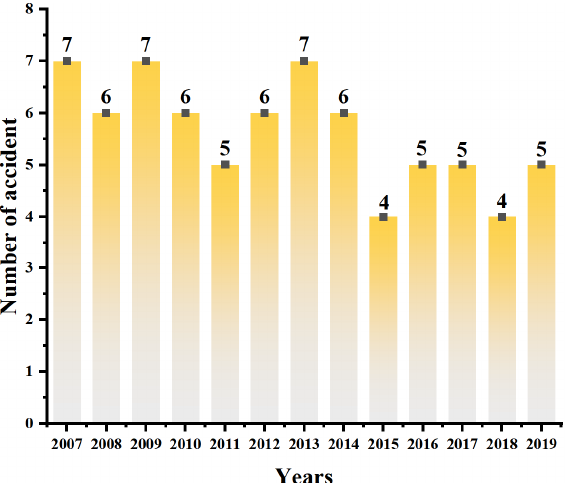
Figure 3. Distribution of ship collision accidents in the study area from 2007 to 2019.